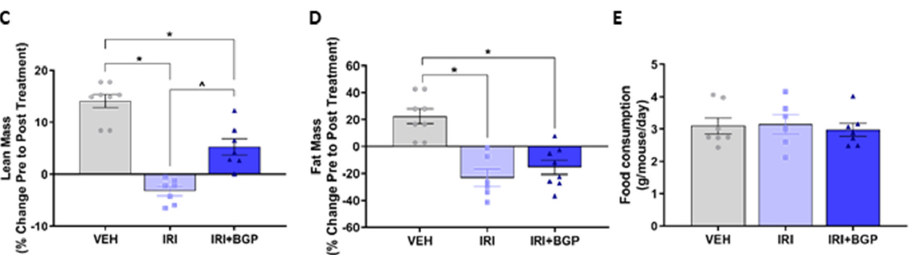
Figure 1. The effect of irinotecan (IRI) and IRI with BGP-15 (IRI+BGP) treatment on body composition indices and food consumption. Body composition parameters were measured pre- and post-treatment with body mass presented as ( A ) percentage change from Pre to Post treatment and ( B ) relative displacement percentage compared to vehicle (VEH) from Pre to Post treatment. ( C ) Lean and ( D ) fat mass are presented as a percentage change from Pre to Post treatment. ( E ) Food consumption was monitored throughout the treatment period. * = p < 0.05 compared to VEH; ^ = p < 0.05 compared to IRI; n = 7–8.